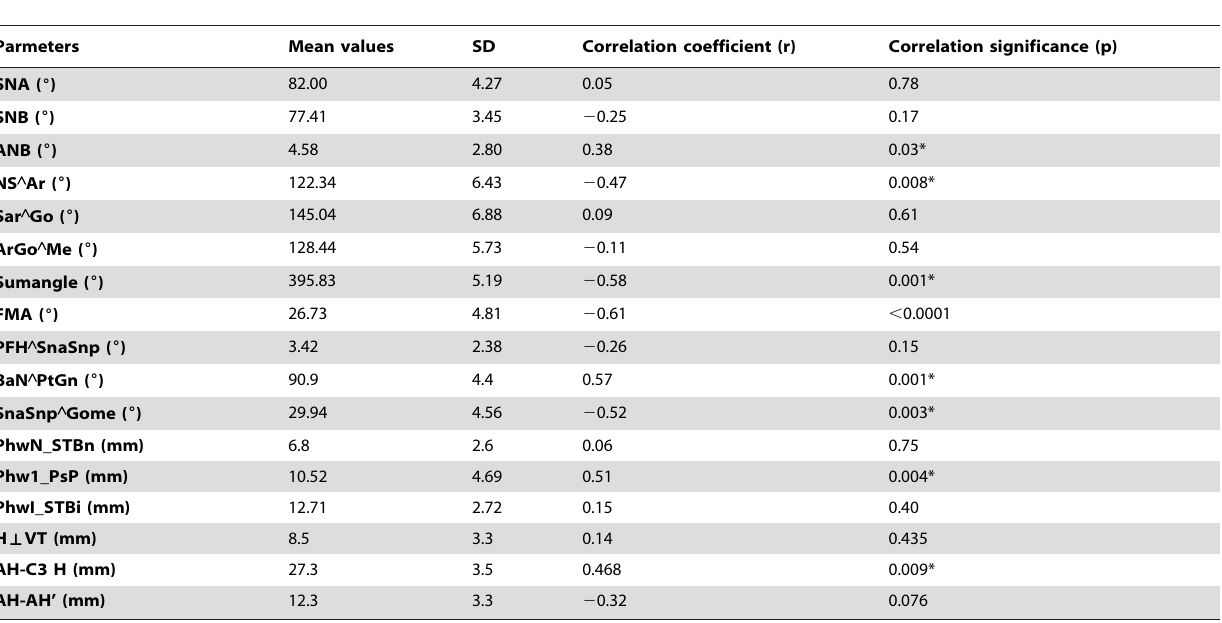
Table 2. Cephalometric parameters in our sample of children with primary snoring and their correlation with nasal patency as fraction of predicted values of nasal flows expressed by Pearson’s correlation